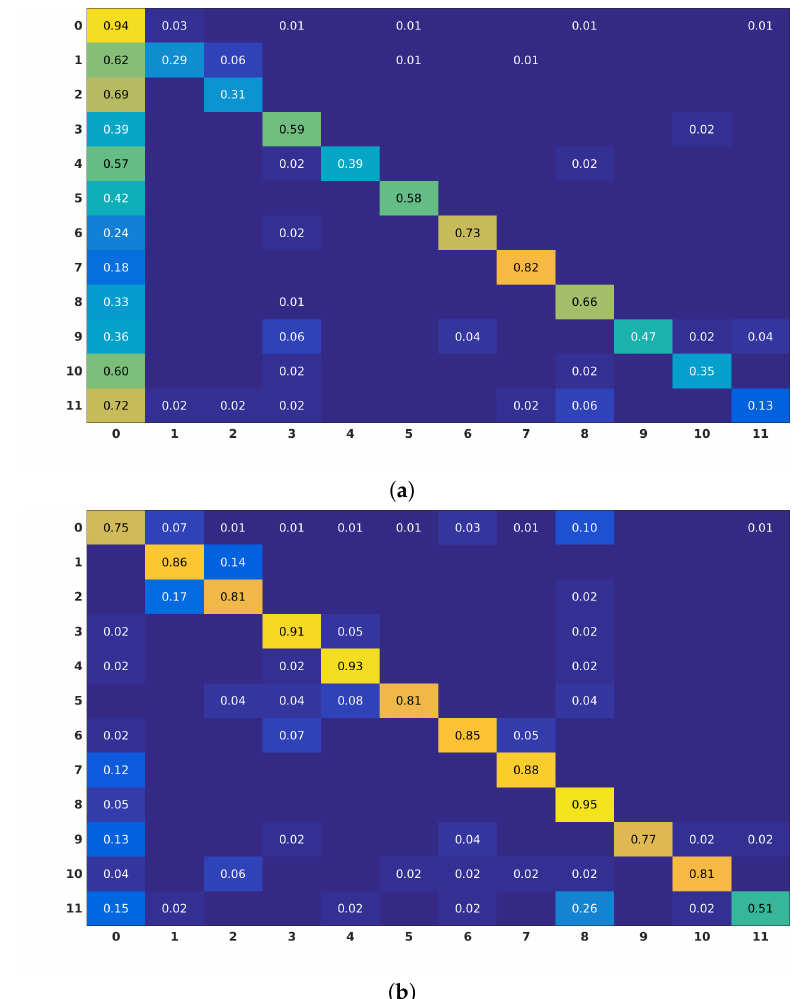
Figure 7. Confusion matrices obtained for Dense Trajectories ( a ) and 2D Localized Trajectories ( b ) approaches (Watch-n-Patch) in the kitchen environment. The action labels are: (0) no-action; (1) fetch-from-fridge; (2) put-back-to-fridge; (3) prepare-food; (4) microwaving; (5)